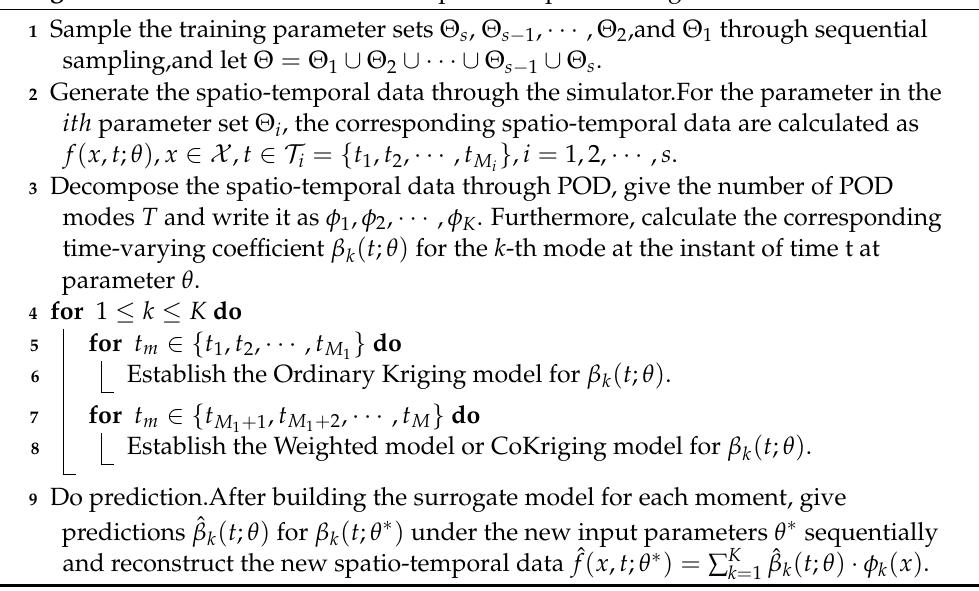
Algorithm 1: The framework for the spatio-temporal surrogate